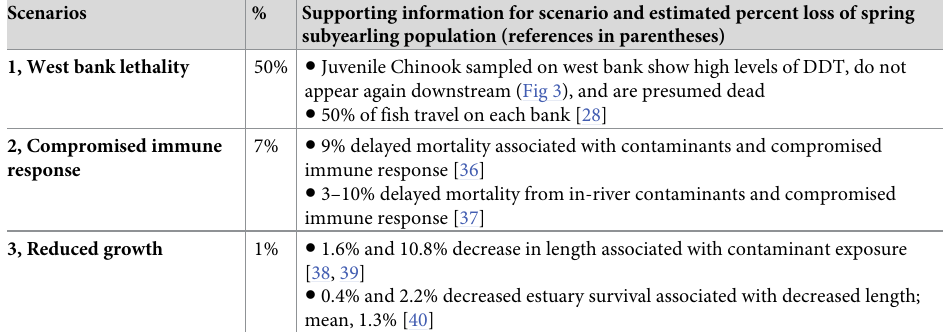
Table 1. Summary of proposed effects associated with toxicant exposures, and estimated percent loss of spring subyearling population.